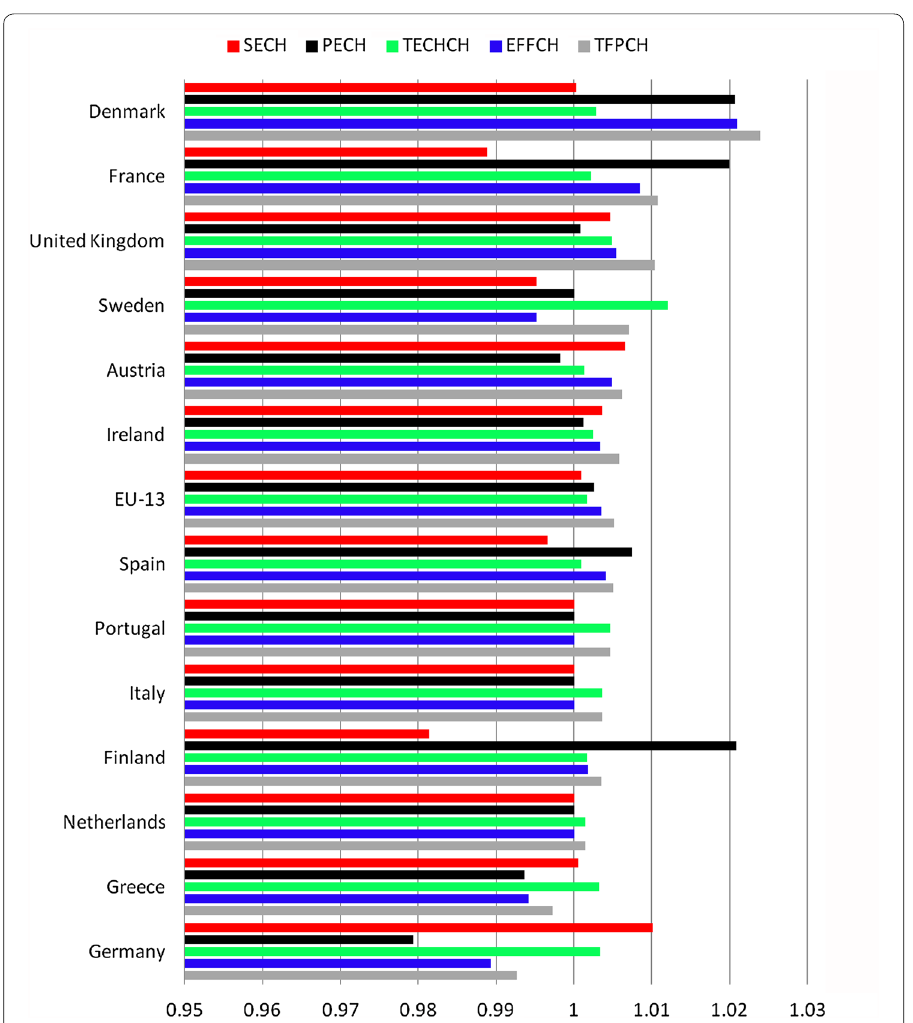
Fig. 6 Annual means of Malmquist index and its components. In this figure, countries are sorted in ascend- ing order by the TFPCH